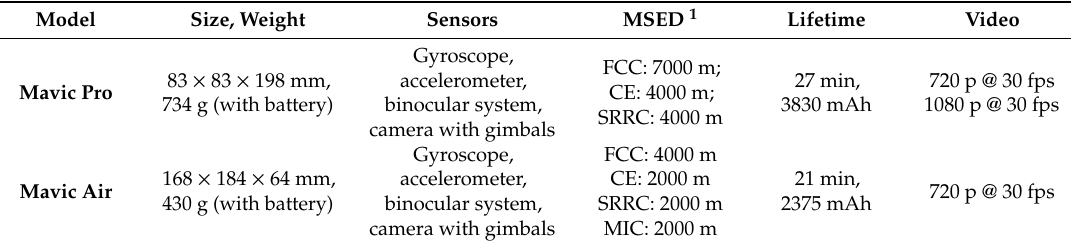
Table 1. Overview of the testbed.